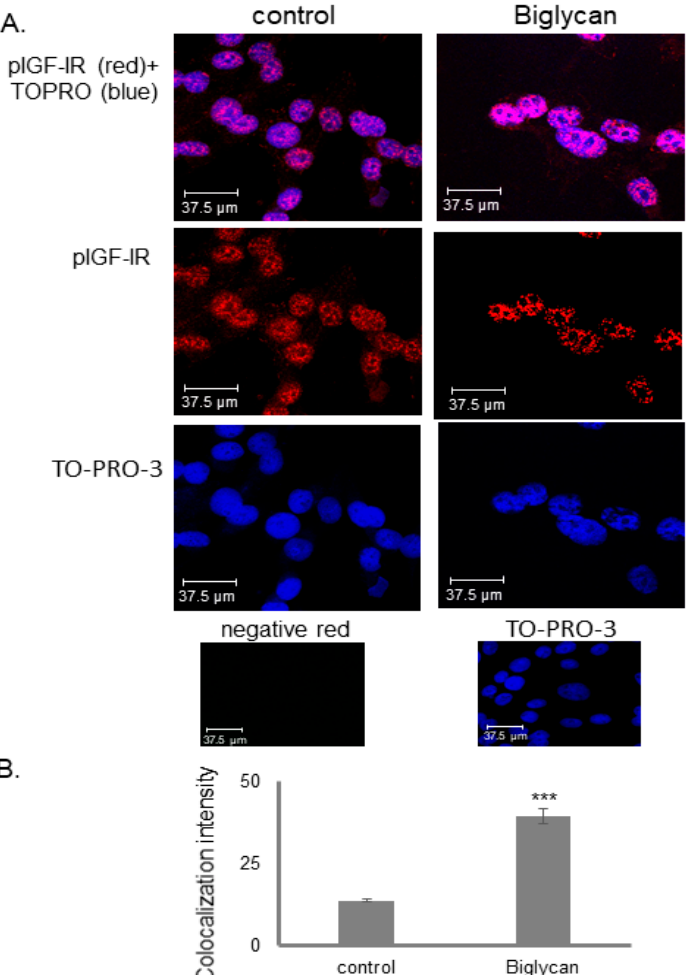
Figure 7. Co-localization of pIGF-IR with DNA in MG63 cells. ( A ) pIGF-IR(red; anti-mouse Alexa Fluor 488) protein staining of cells and respective nuclear staining (using TO-PRO-3) were evaluated in cultures after 48 h in serum-free medium (control) or biglycan (10 μ g/mL). In negative controls, primary antibody was omitted, but secondary antibody was used (anti-mouse negative red). Slides were analyzed by confocal microscopy and pictures were taken using ×40 magnification. ( B ) Intensity measurement of colocalization of pIGF-IR with DNA was calculated using ImageJ Analysis Software. Representative pictures are presented. Results represent the average of three separate experiments. Statistical significance: *** p ≤ 0.001 compared with the respective control samples.